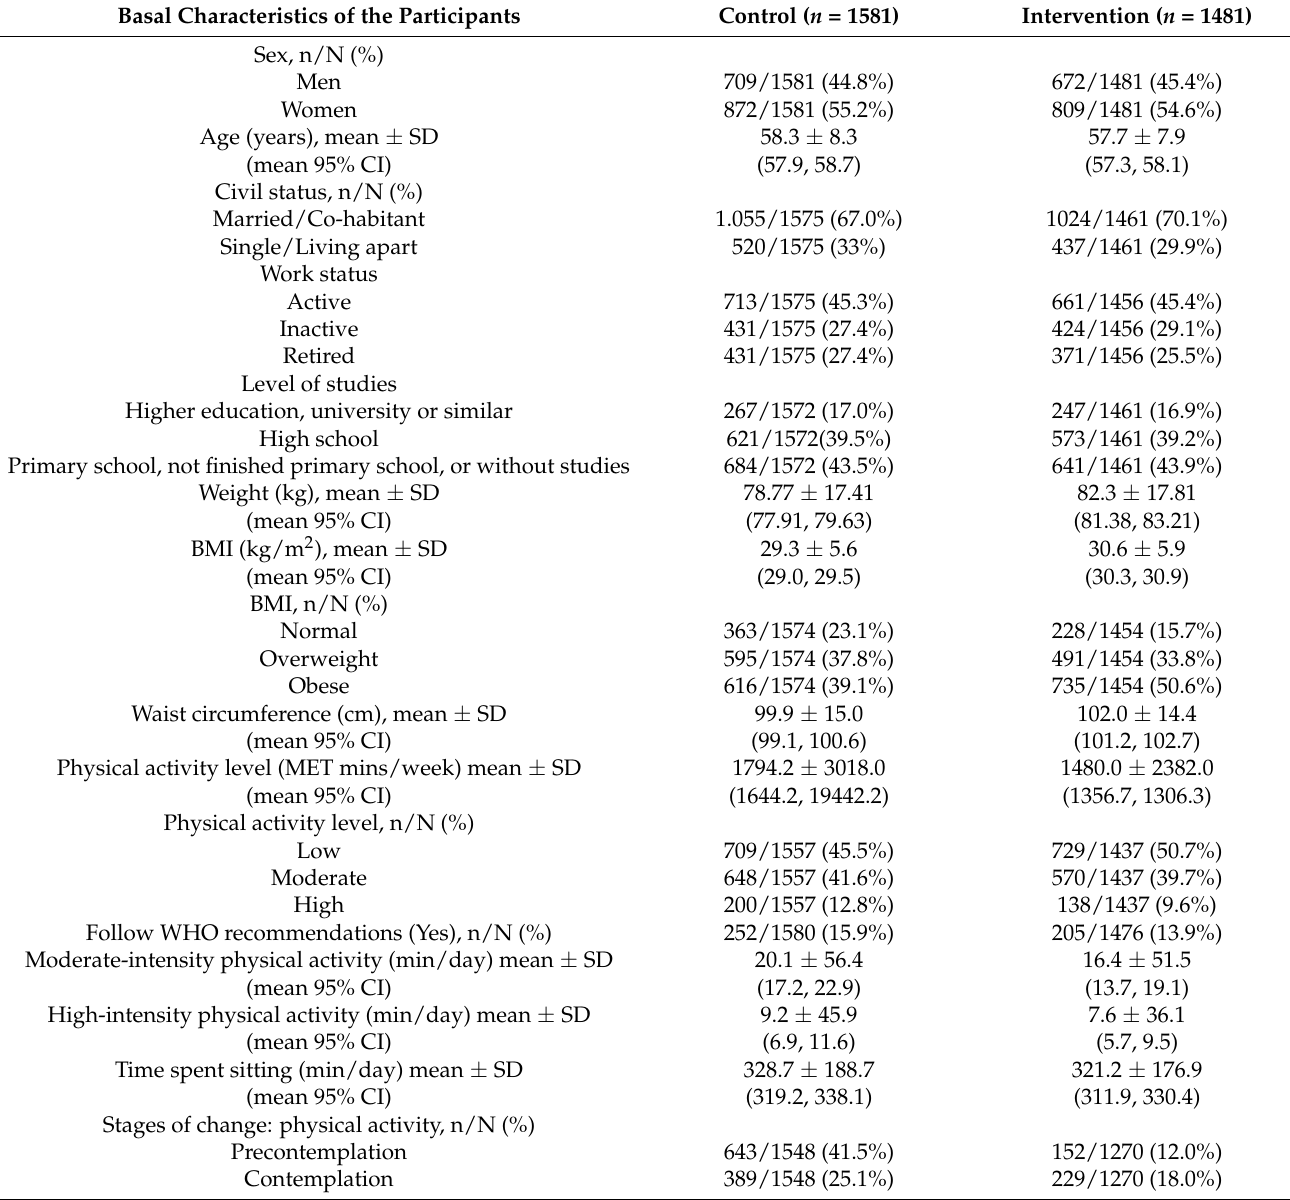
Table 1. Baseline characteristics of participants in the control and intervention